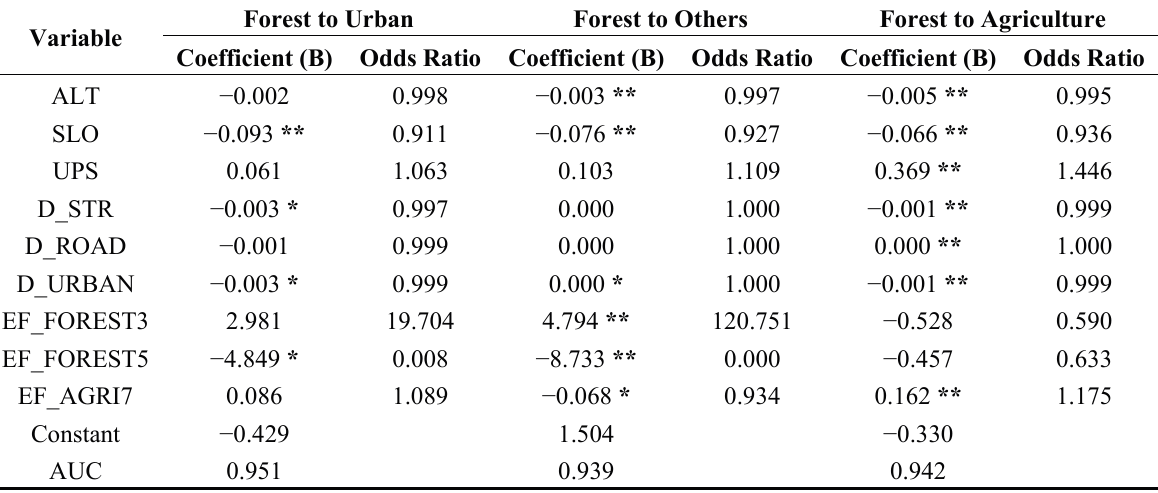
Table 6. Factors of forest land-use changes using logistic regression (1990~2000). Variable